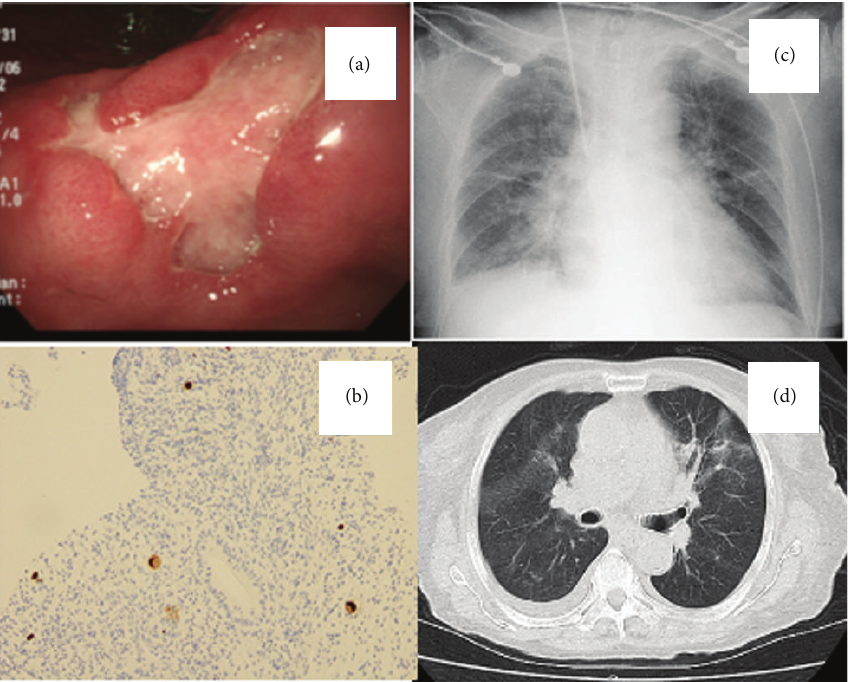
Figure 1: The opportunistic infections in the two HTLV-1-positive patients. (a) Gastric ulcers. (b) Positive staining of cytomegalovirus in a stomach biopsy (original magnification, × 400), from case 1 . (c) Chest X-ray and (d) chest computed tomography images of the lungs showing fine nodular shadows and ground glass opacity, from case 2 .